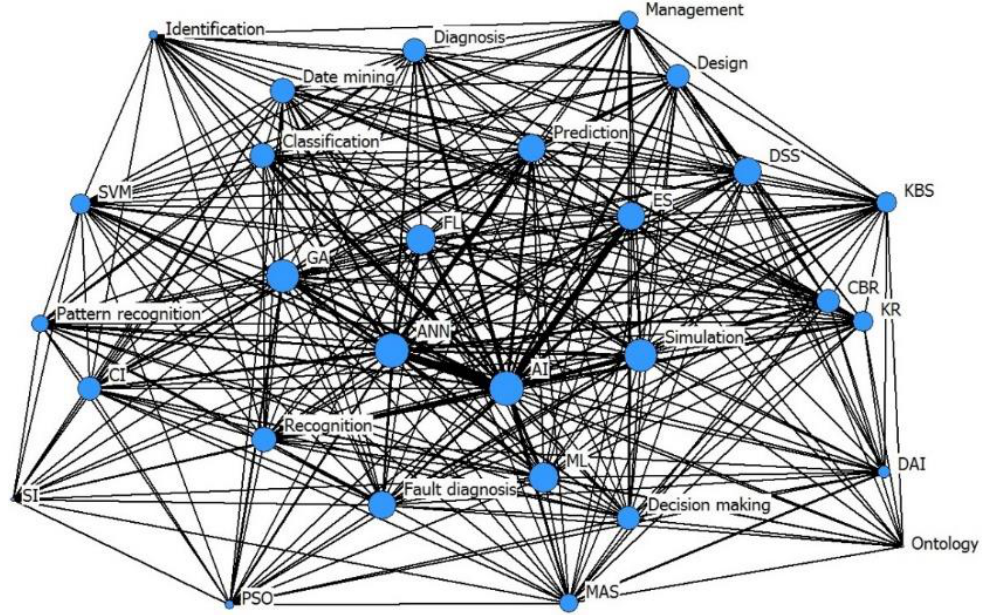
Figure 8. Co-word network of top 30 high-frequency keywords in artificial intelligence.